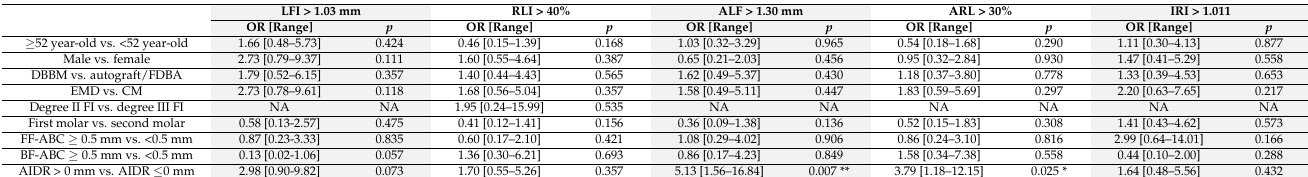
Table 6. Logistic regression for the effects of the demographic characteristics, treatment strategies, furcation–ABC relationship, and AIDR in achieving a better outcome of FDR in the combined furcation–angular defect